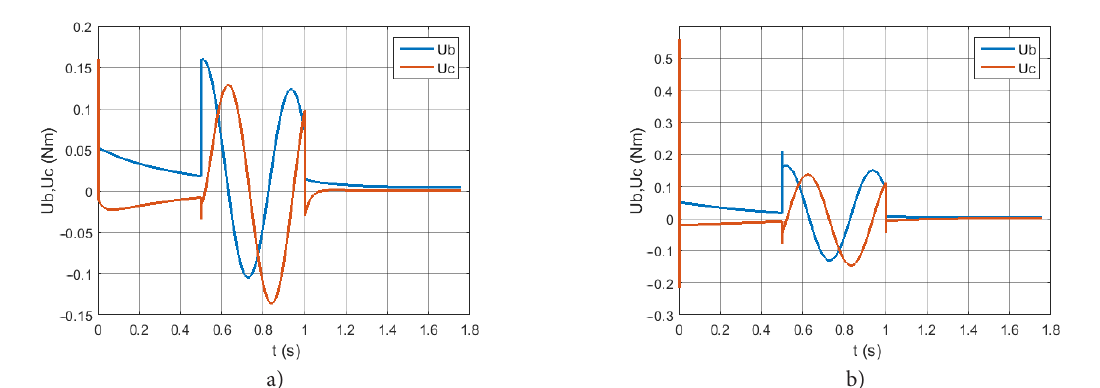
Figure 13. Control moments over time, for: a) LQR, b) PD